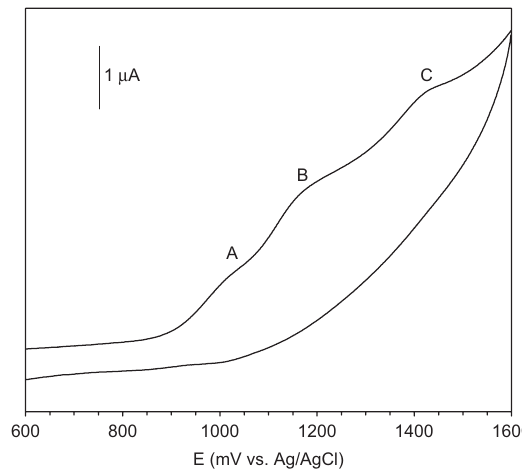
Figure 2 Cyclic voltammogram for the oxidation of 30 µ g/ml carvedilol in acetonitrile containing 0.1 m TBAClO trode, scan rate: 0.2